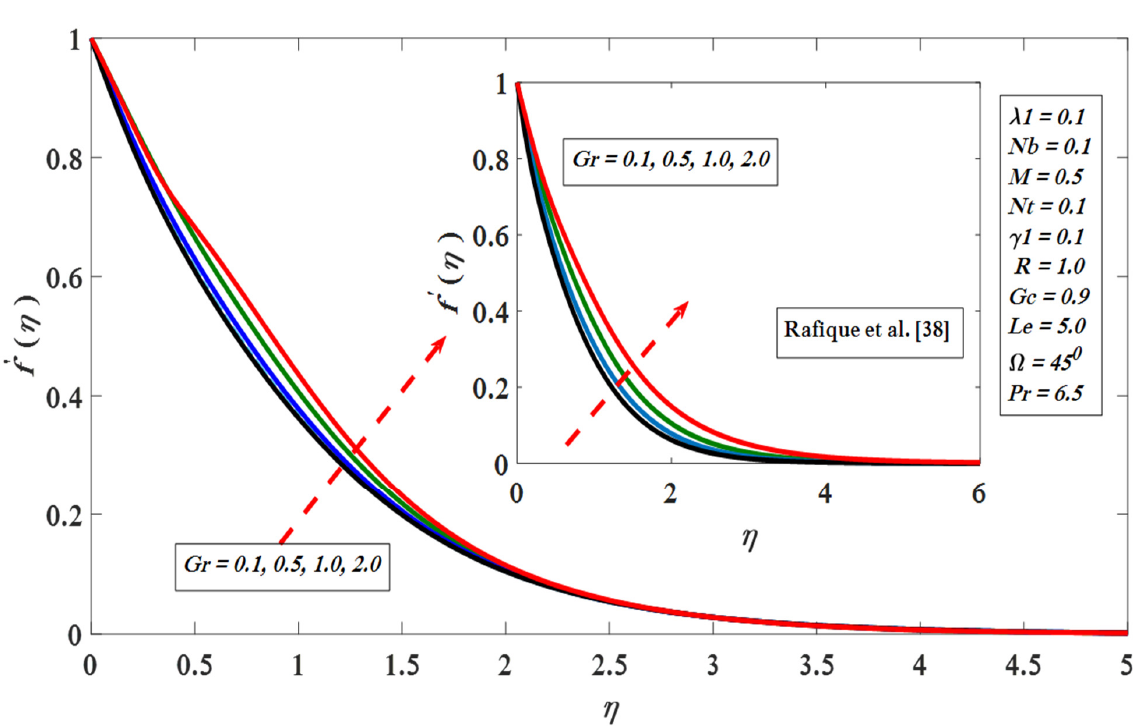
Figure 3. Velocity profile versus Gr